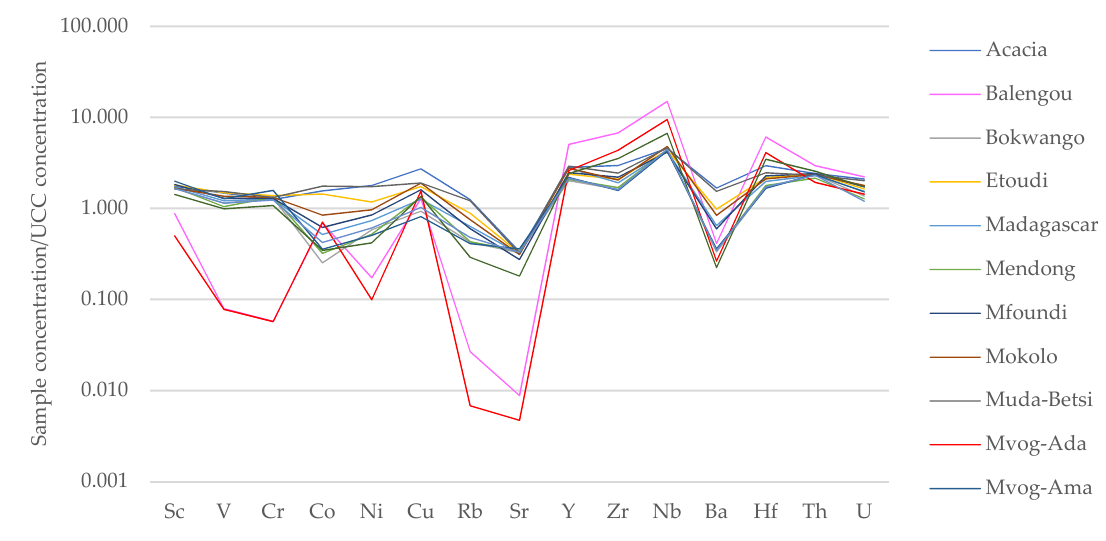
Figure 5. Spider diagrams showing upper continental crust (UCC)-normalised trace elements in the studied geophagic clays. The UCC-normalised rare earth elements (REEs) showed enrichment in all the geophagic clays, except the Mvog-Ada clays, which were depleted in Eu (Figure 6). All samples also portrayed a negative europium anomaly (Eu/Eu*) ranging from 0.18 (Mvog-Ada) to 0.95 (Muda-Betsi).